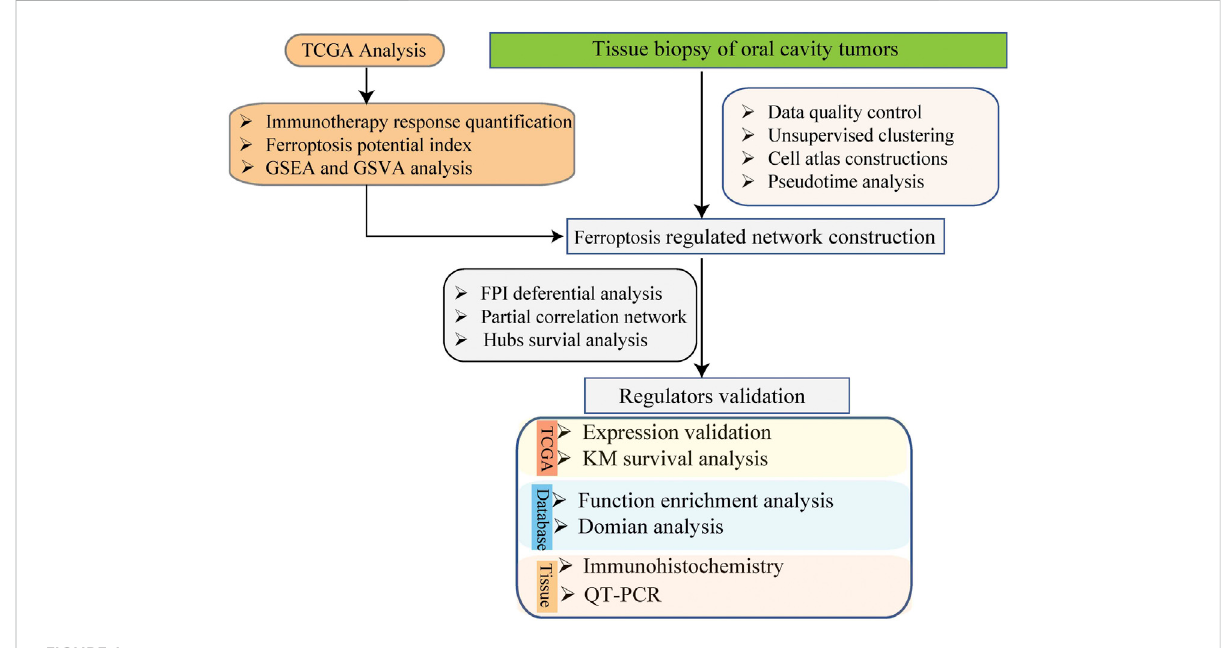
FIGURE 1 The schema of the study